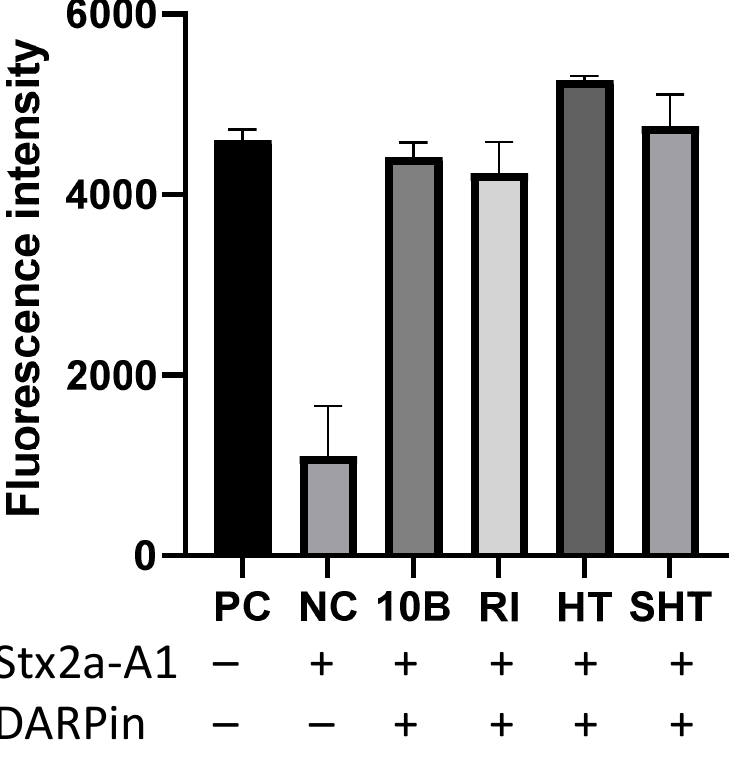
Figure 4. DARPin molecules protect ribosomes from intoxication by Stx2a-A1 in vitro. Purified Stx2a-A1 (2.5 µ M) was incubated with DARPin molecules (final 10 µ M) in PBS supplemented with BSA (40 mg/mL) for 30 min at 37 ◦ C before being added to the 1x NEBExpress Cell-free E. coli protein synthesis system, which contains both the translation and transcription machinery. The mixture was incubated at 37 ◦ C for 30 min before the addition of a reporter plasmid encoding GFP, and the protein synthesis was continued at 37 ◦ C for 6 h, followed by overnight incubation at 4 ◦ C to ensure complete folding of GFP. The amount of GFP produced was quantified using a fluorescent plate reader and compared to that obtained from reactions lacking any toxin (positive control, PC) and reactions with toxin, but without any DARPin (negative control,